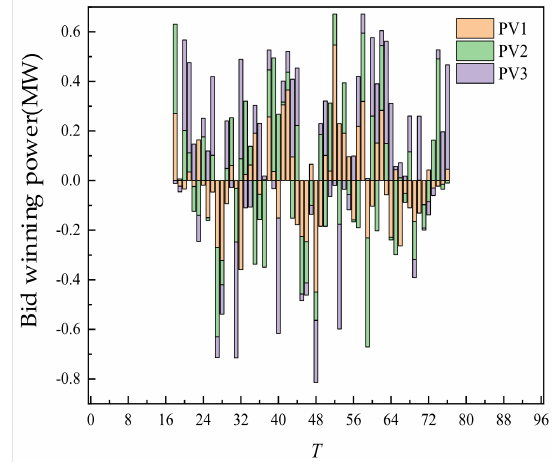
Figure 14. Intra-day trading of PV.